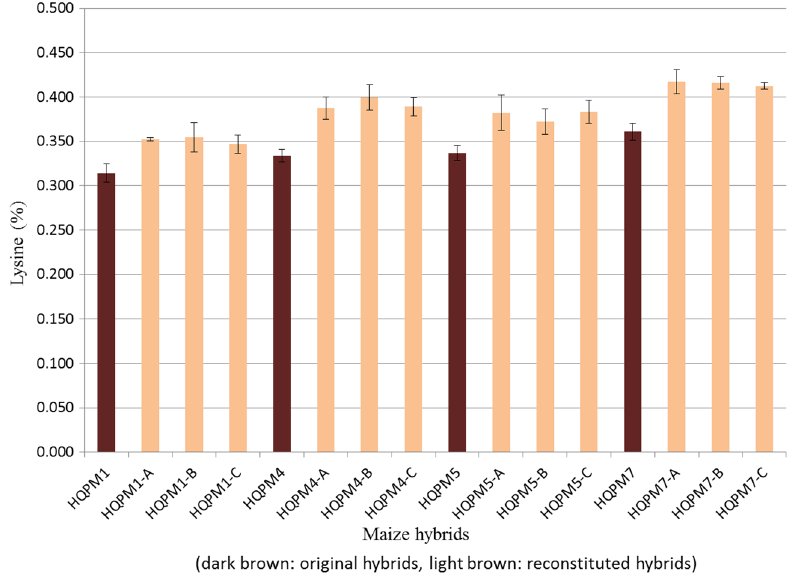
Figure 6. Lysine concentration in original- and reconstituted